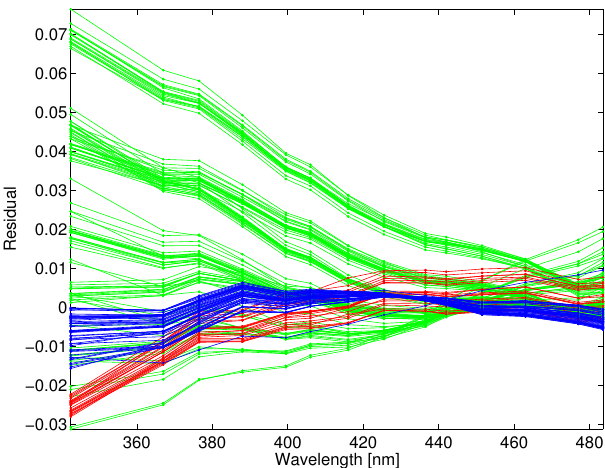
Fig. 2. The spectral differences between the observed reflectance and the reflectance for the best fit models. Each colour represents a set of residuals for pixels from a selected orbit. The residuals cor- respond to different atmospheric situations: dust storm in Sahara (green), wildfires in Russia (red) and when weakly absorbing mod- els dominate